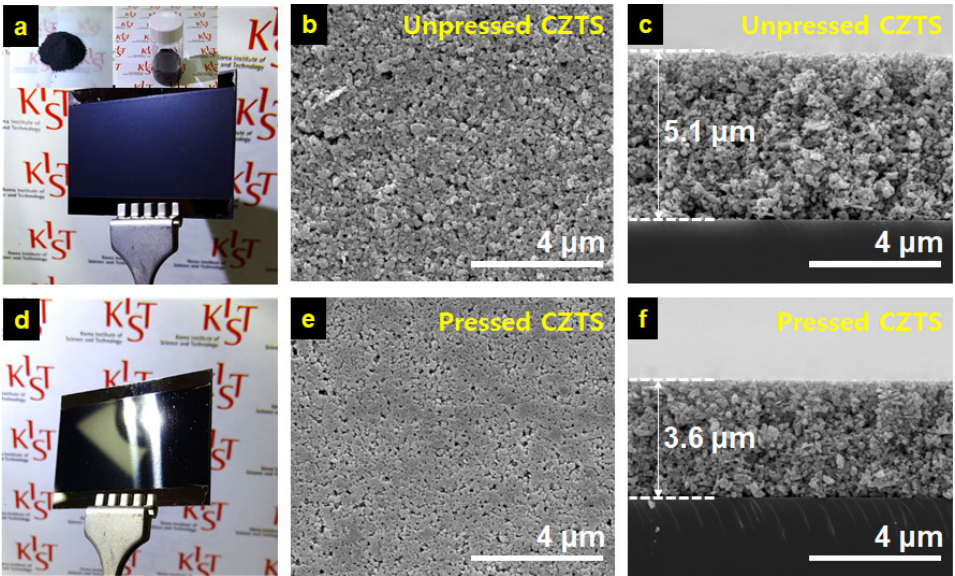
Figure 2. Photographic, top view, and cross ‐ sectional SEM images of ( a – c ) unpressed and ( d – f ) pressed CZTS coats on SLG. Insets in ( a ) represent photographic images of the CZTS powder and its ethanol suspension from left to right.